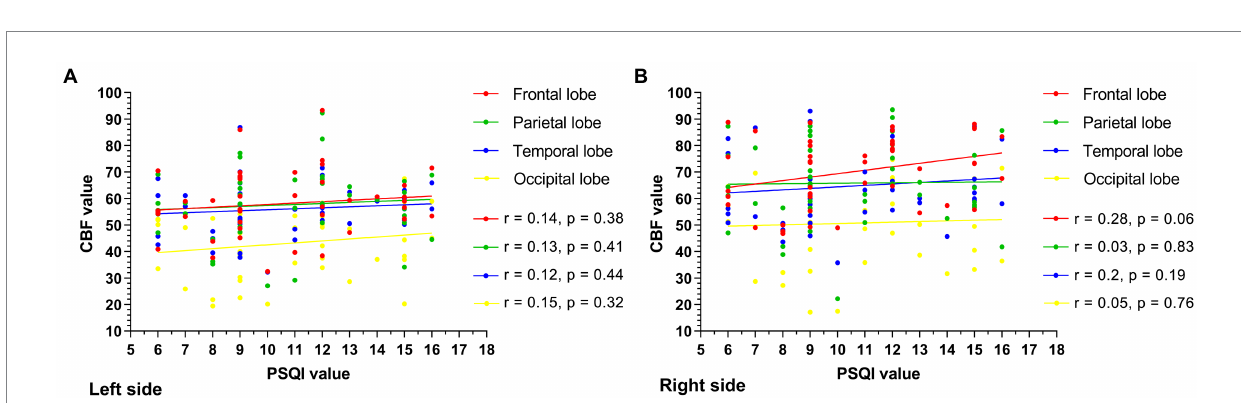
FIGURE 3 The scatter plot between the CBF value and the PSQI value is shown. The CBF values were not correlated with PSQI values in the left (A) , right (B) frontal, parietal, temporal, and occipital lobes, and all the p values of the left and right cerebral lobes exceeded